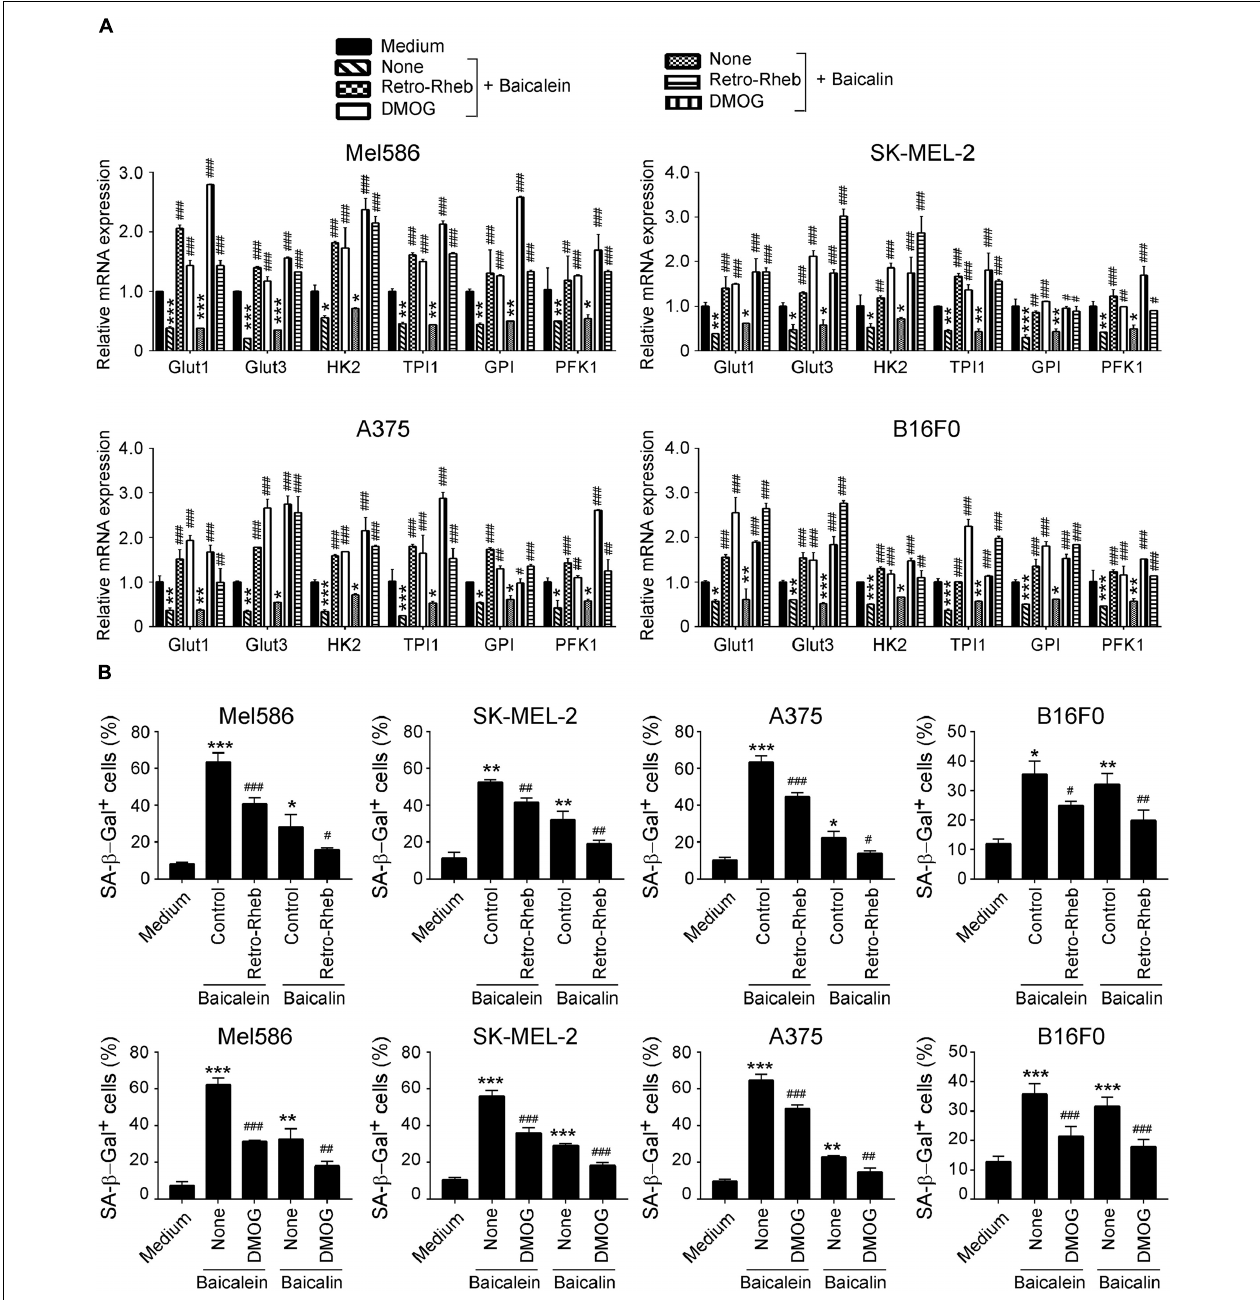
FIGURE 7 | mTORC1-HIF α signaling controls glucose metabolism inhibition and senescence induction in melanoma cells mediated by baicalein and baicalin. (A) Activation of mTORC1-HIF α signaling blocked baicalein and baicalin-induced down-regulated gene expression of key glycolytic enzymes in both human and mouse melanoma cells. Melanoma cells were transfected with Retro-Rheb plasmid or pretreated with DMOG (0.1 mM) for 24 h, then cultured for 3 days in the presence of 40 µ M of baicalein or baicalin. Total RNA was isolated from the tumor cells and analyzed by Real-time PCR. The expression levels of each gene were normalized to β -actin expression levels and adjusted to the levels in untreated tumor cells (medium). Data shown in different melanoma cells are mean ± SD from three independent experiments. * p < 0.05, ** p < 0.01, and *** p < 0.001, compared with the medium control group. # p < 0.05, ## p < 0.01, and ### p < 0.001, compared with the respective baicalein or baicalin treatment group. (B) Activation of mTORC1-HIF α signaling prevented senescence induction in melanoma cells mediated by baicalein and baicalin. Cell treatment and procedure are identical to panel (A) . Treated melanoma cells were cultured for 3 days in the presence of baicalein or baicalin (40 µ M for Mel586, A375, and SK-MEL-2 cells, and 50 µ M for B16F0 cells). Senescent cells were analyzed using the SA- β -Gal activity assay. Data shown are mean ± SD from three independent experiments with similar results. * p < 0.05, ** p < 0.01, and *** p < 0.001, compared with the medium control group. # p < 0.05, ## p < 0.01, and ### p < 0.001, compared with the respective baicalein or baicalin treatment group.